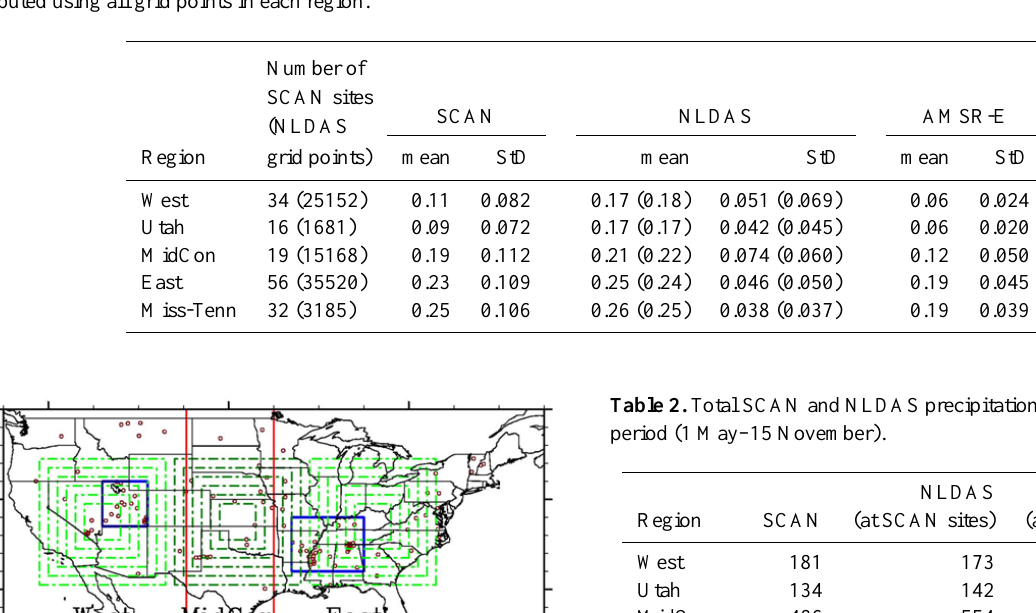
Table 1. The number of SCAN stations, temporally averaged (over 198 days) spatial mean and spatial variability (StD) of soil moisture (cm 3 cm − 3 ) in each region. Statistics were calculated using data values at SCAN sites, except the numbers in parentheses, which were computed using all grid points in each region.